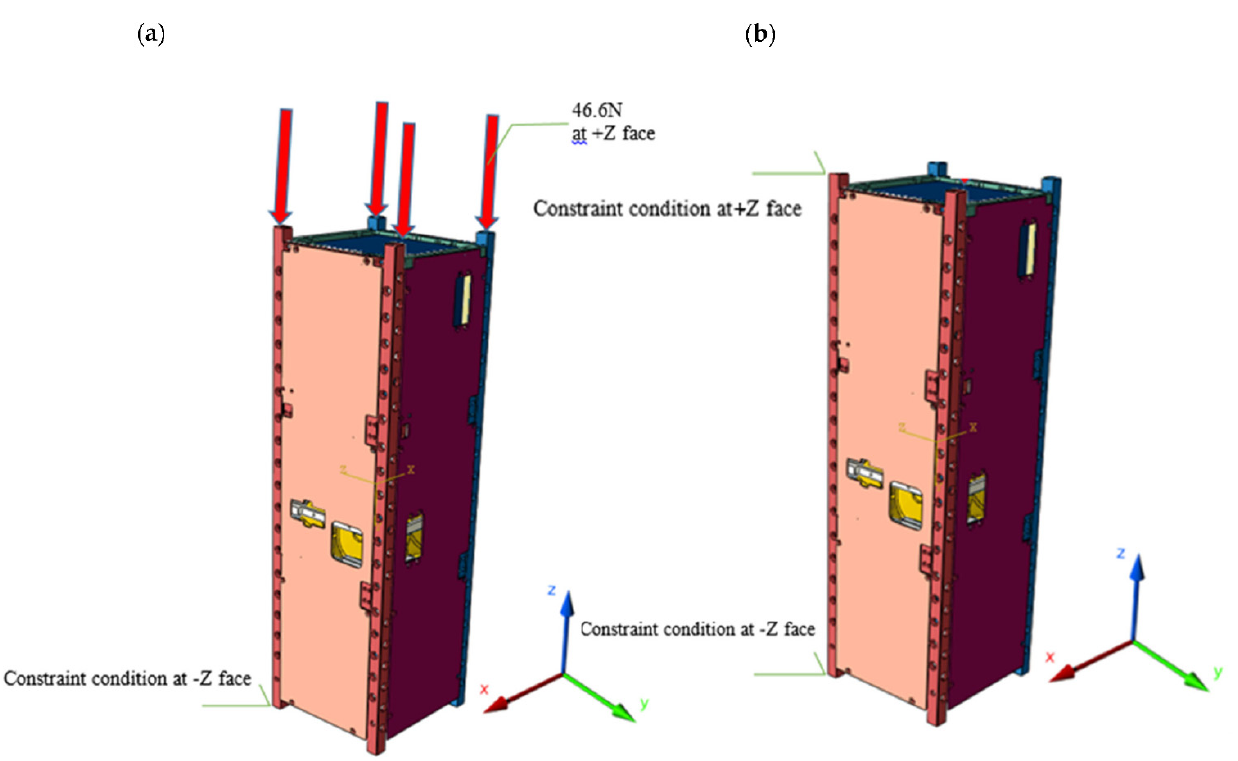
Figure 13. Boundary conditions applied on the rail for ( a ) quasi-static analysis and ( b ) modal analysis.